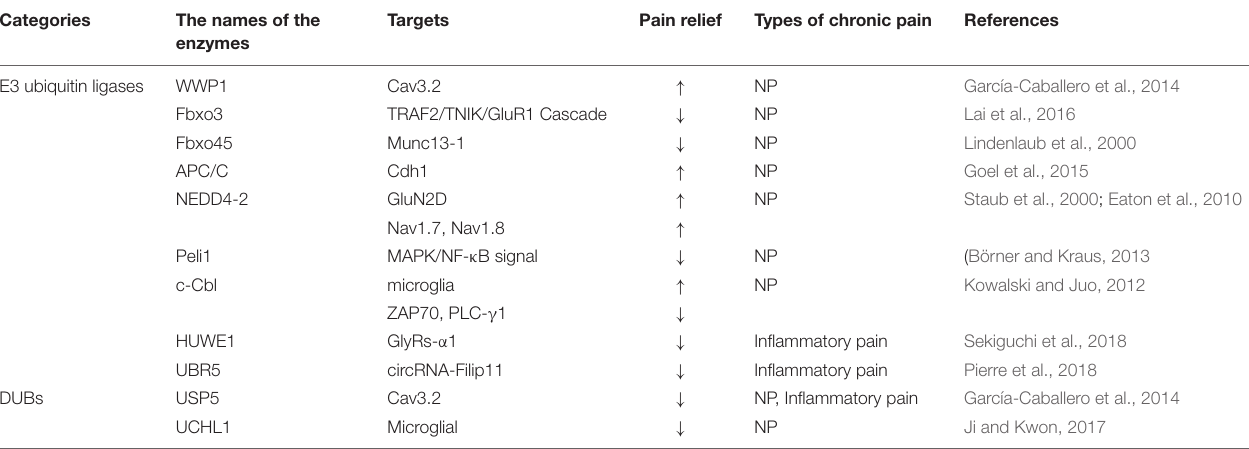
TABLE 2 | Available potential targets of E3 ubiquitin ligases and DUBs for chronic